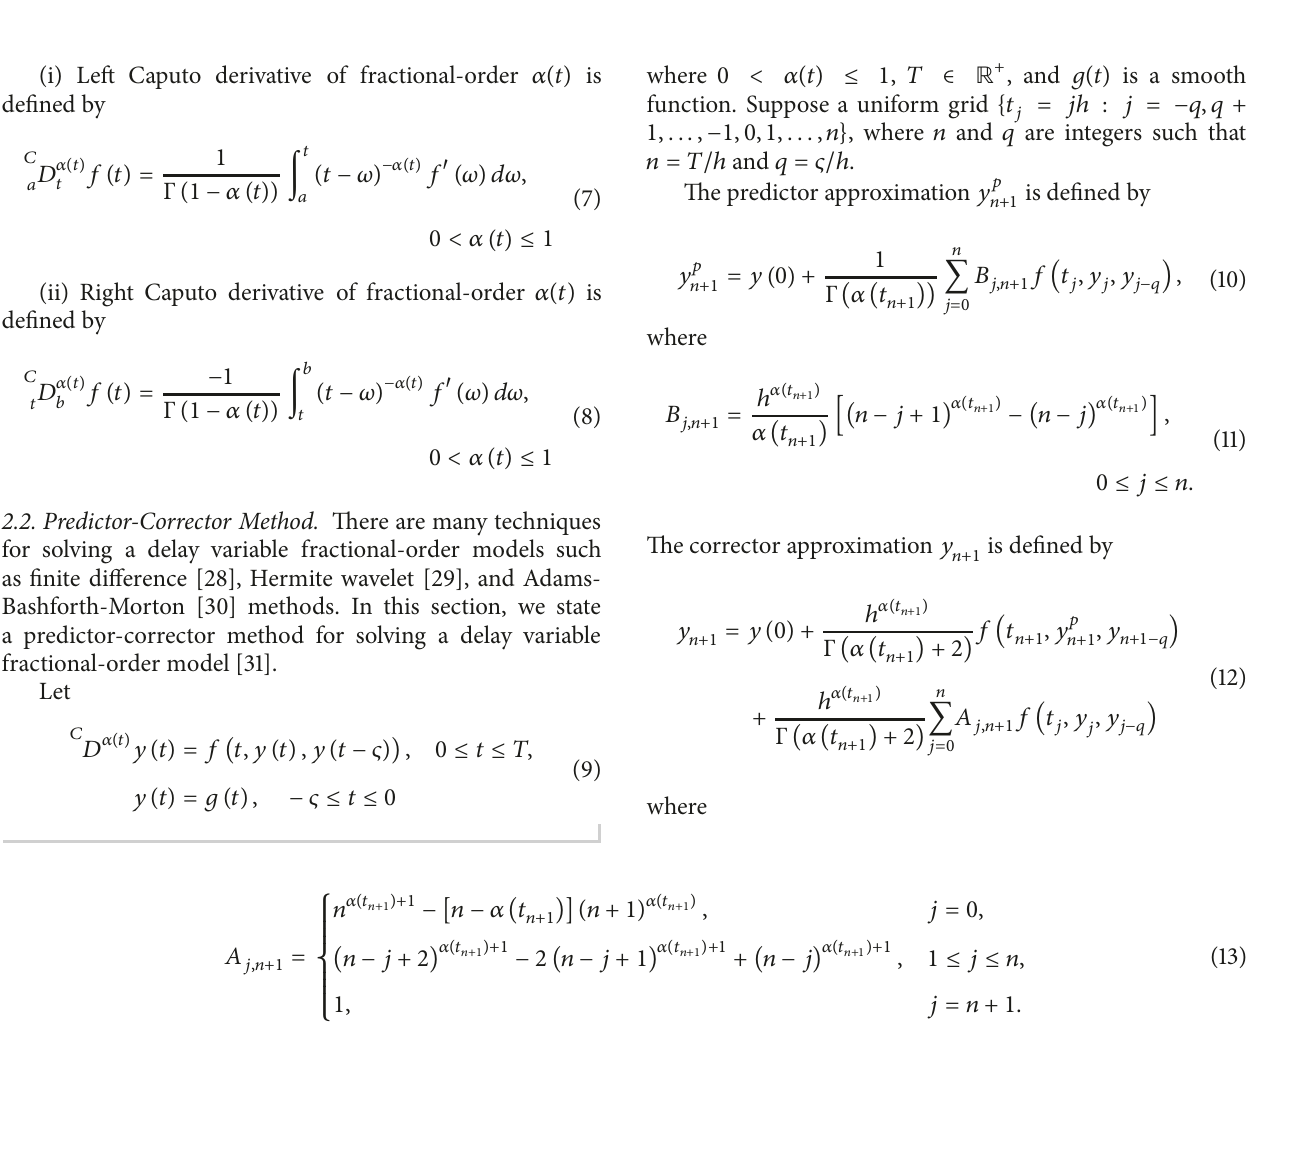
Figure 1: HIV infected individuals showing symptoms of AIDS at 𝛼(𝑡) = 0.8 with ] 2 = 1.5 (solid line), ] 2 = 10 (dashed line), and ] 2 = 100 (dotted line). Parameters values are in Table 1 with 𝛽 ℎ = 0.01